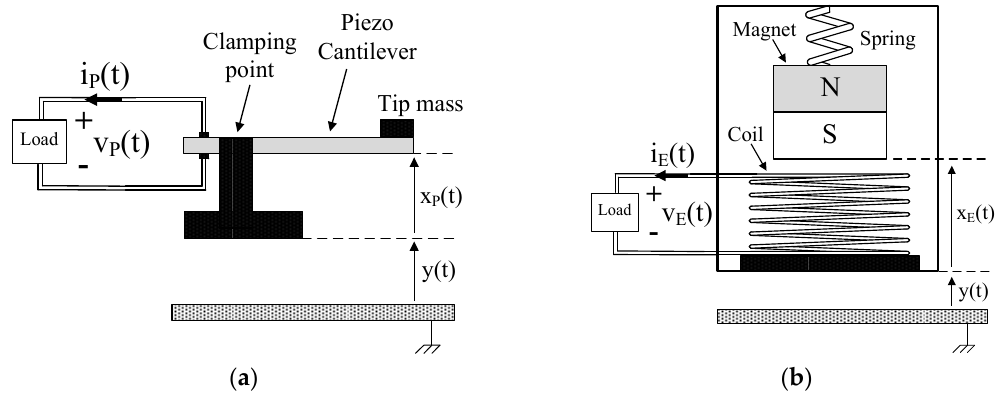
Figure 2. ( a ) Schematic model of a piezoelectric resonant vibration energy harvester (P-RVEH). ( b ) Schematic model of an electromagnetic (E-RVEH).